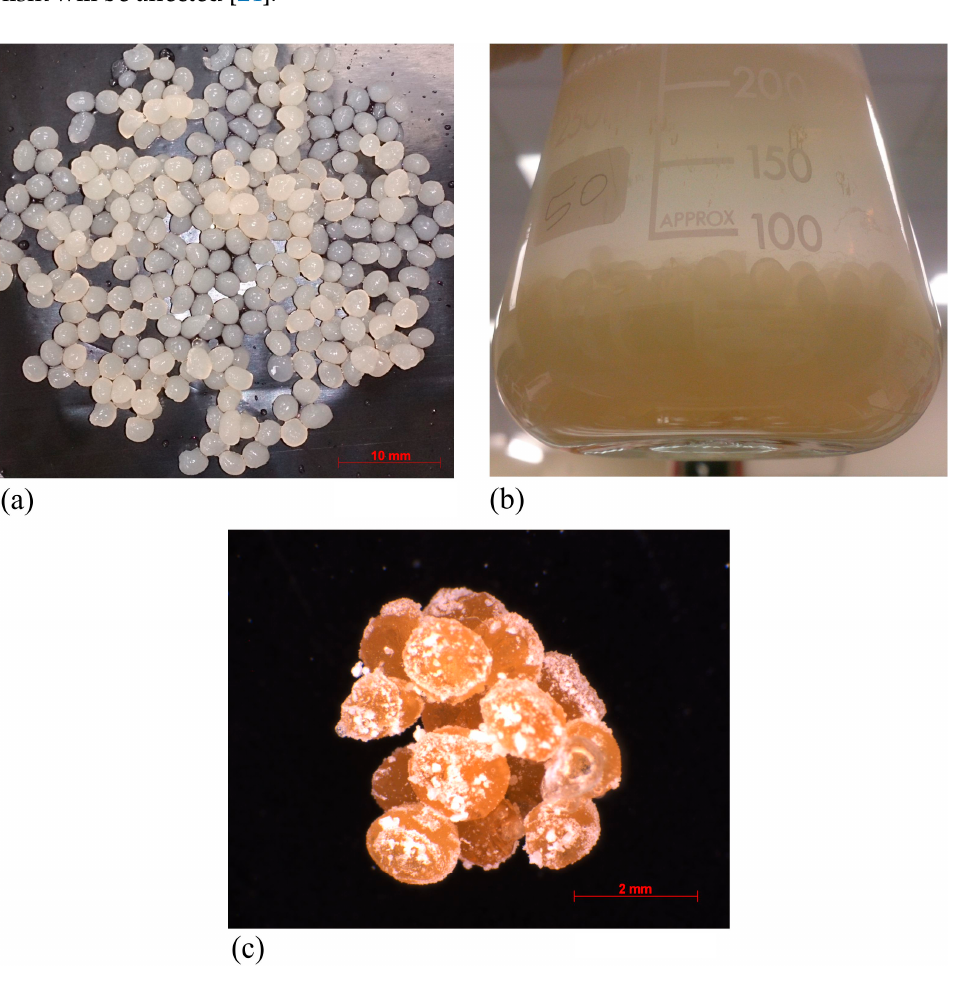
Figure 2. ( a ) Immobilized bacterial cells into Ca-alginate beads; ( b ) fermentation medium inoculated with immobilized bacterial cells; and ( c ) precipitated CaCO 3 crystals around Ca-alginate beads.